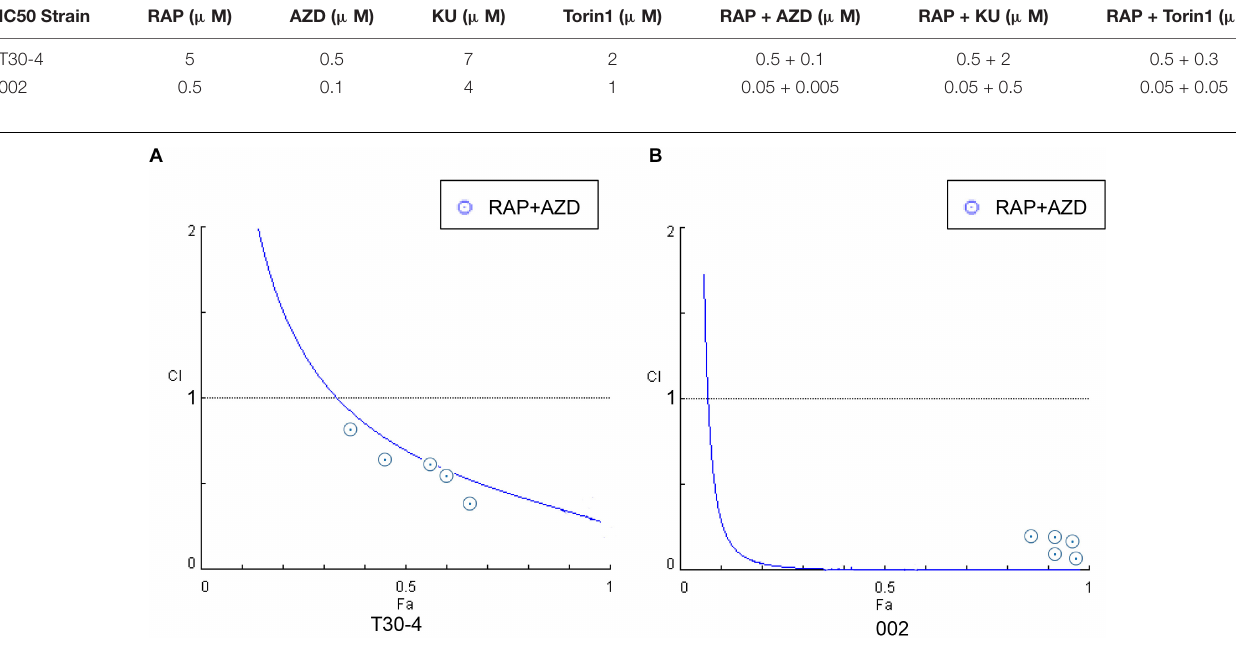
FIGURE 4 | Fa-CI curves were generated by the treatment of P. infestans with RAP + AZD (A) T30-4 and (B) 002. CI < 1: Synergistic effect; CI = 1: Additive effect; CI > 1: Antagonistic effect. Fa (affected fraction): a function of the effect level.